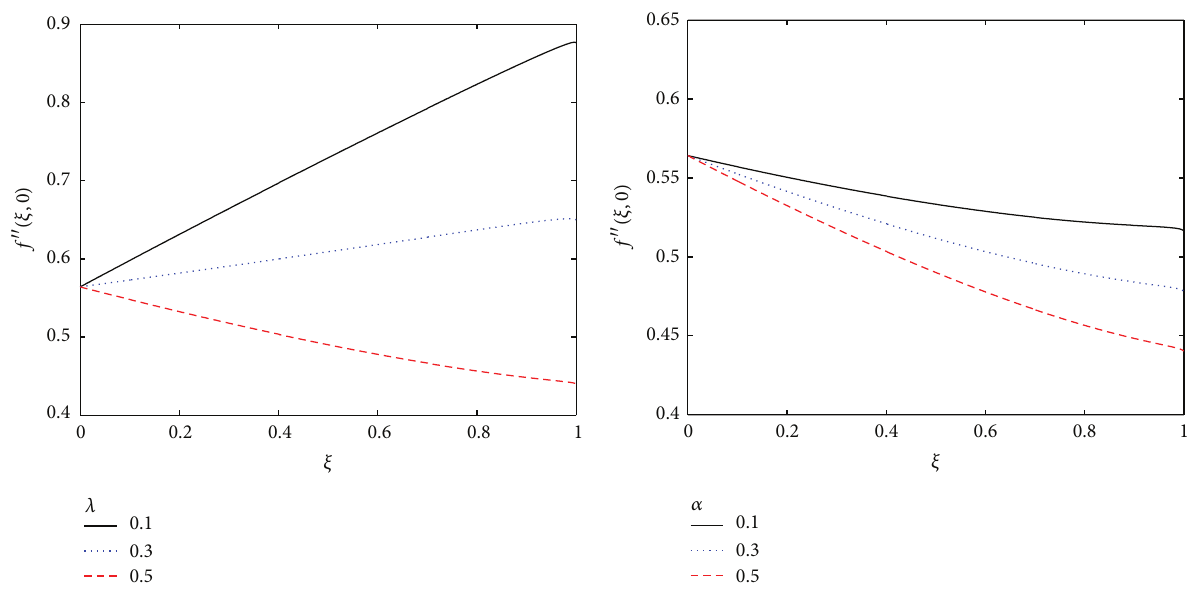
Figure 1: Effect of 𝜆 and 𝛼 on the skin friction coefficient.